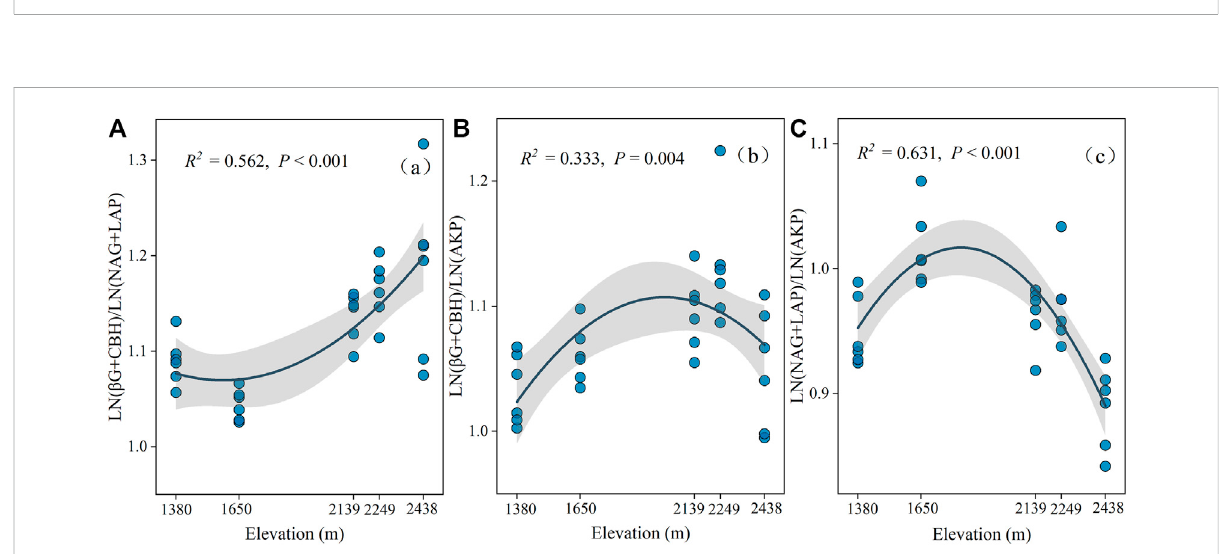
FIGURE 3 The ecoenzymatic stoichiometry of Ln (BG + CBH): Ln (NAG + LAP) (A) , Ln (BG + CBH): Ln (AKP) (B) , Ln (NAG + LAP): Ln (AKP) (C) at different altitudes.